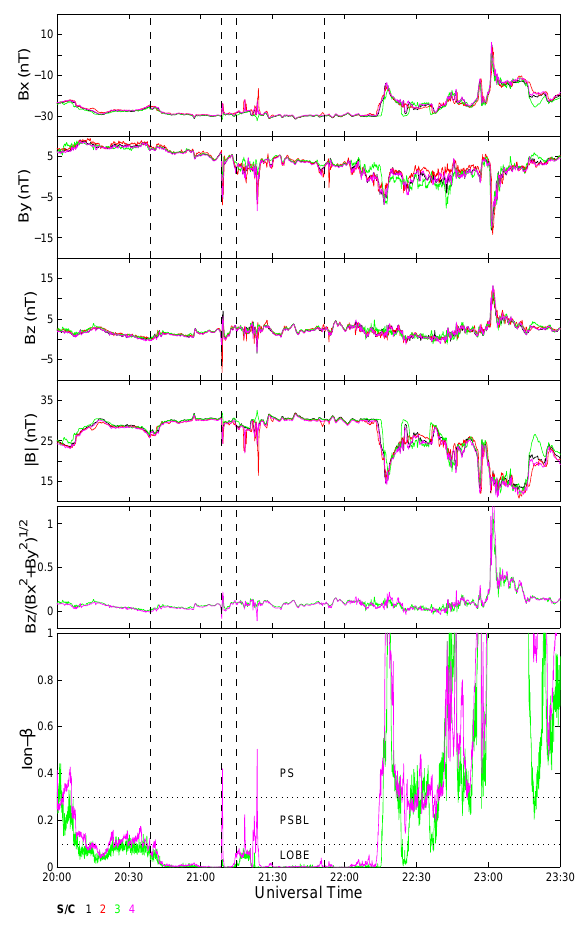
Fig. 10. First four panels show magnetic field data from Cluster. Panel five shows the ratio of the vertical and horizontal magnetic field components. Bottom panel shows ion beta value calculated with ion data from s/c 3 and 4. Typical values of the lobe, PSBL, and plasma sheet regions are indicated with the dotted horizontal lines.